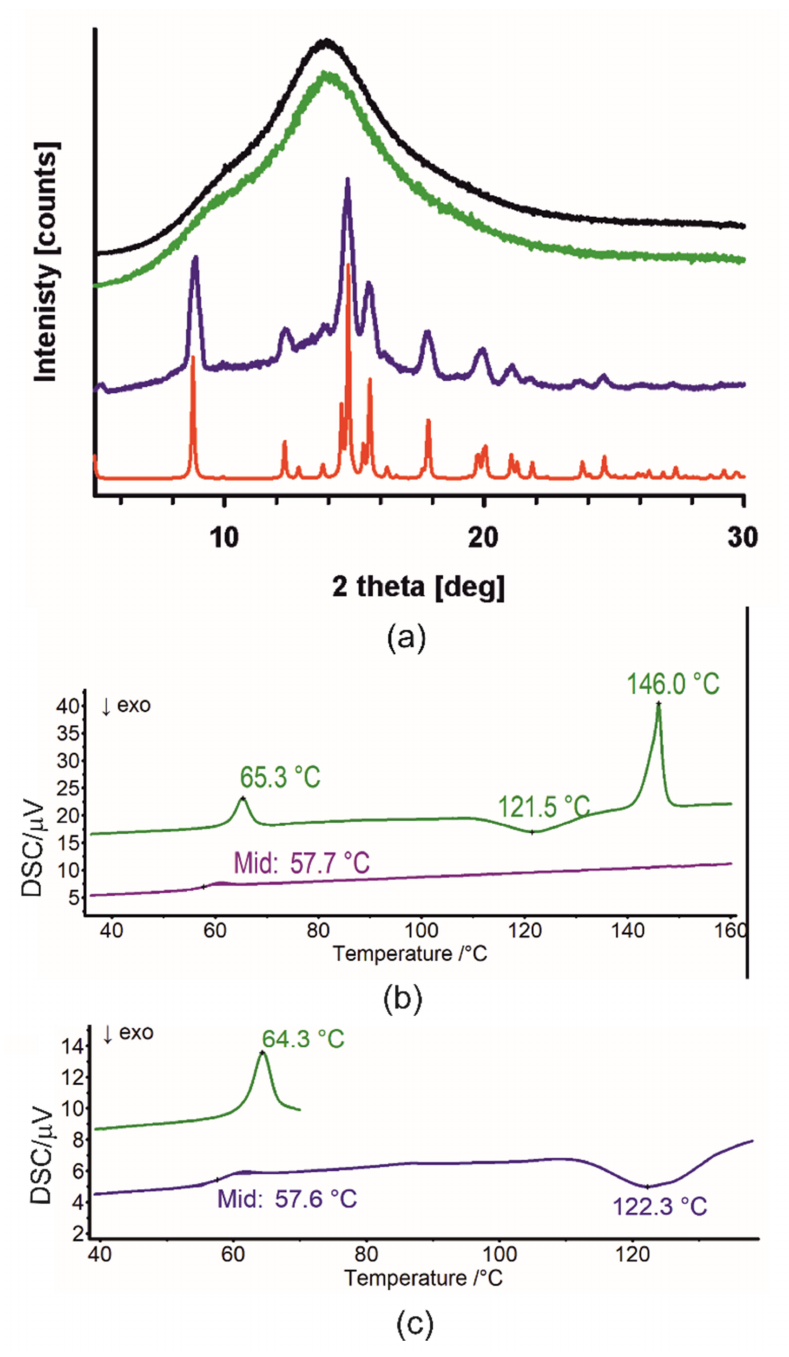
Figure 6. PXRD patterns ( a ) of the but-OA ester: starting amorphous sample (black), after heating to 70 ◦ C (green) and 138 ◦ C (purple), and simulated based on the P 2 1 -but-OA crystal structure (red). DSC thermograms ( b , c ) of the amorphous form of the but-OA ester: green 1st heating and purple 2nd